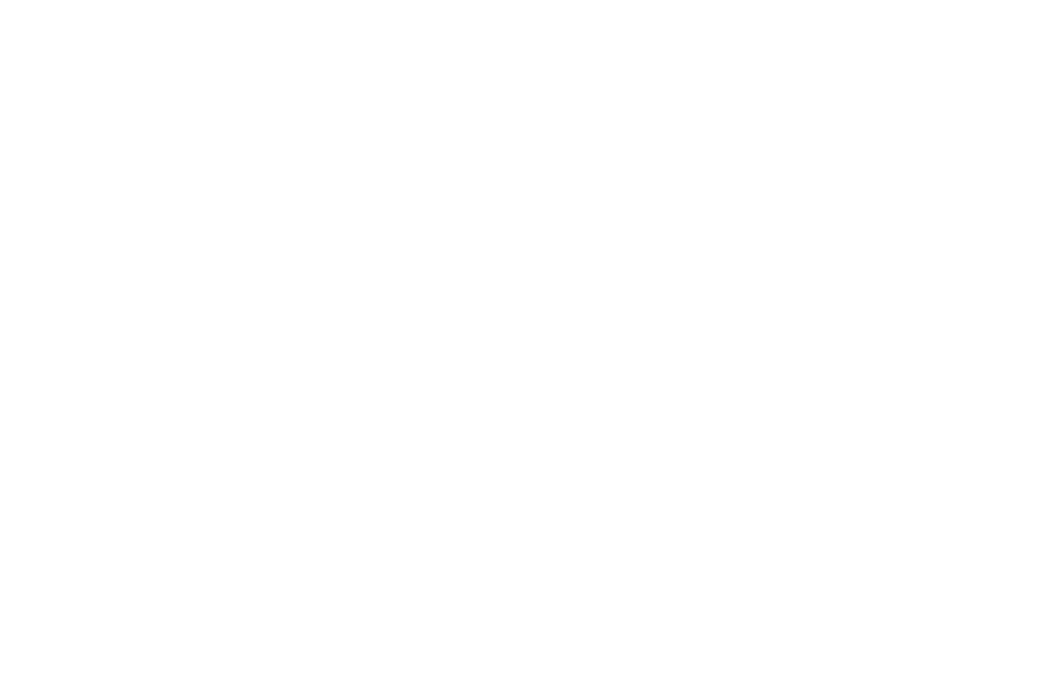
Figure 4. Non-local correlations for n x 1 1 0 ϕ in the absence of the intrinsic decoherence with different values of α : α √ 2 [| ↑ | � = � + | ↓ �] α π/ 3 in ( b =